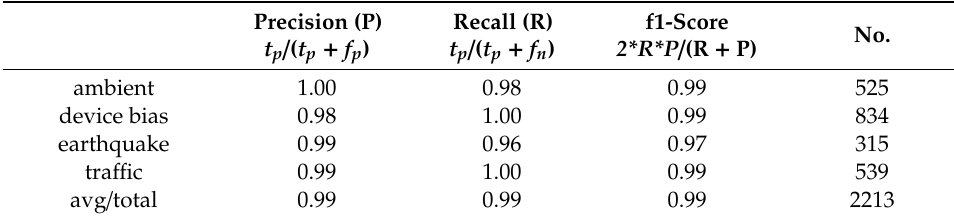
Figure 10. Confusion matrix for CNN model with augmented dataset. Table 4. Precision, recall, and f1-score for augmented